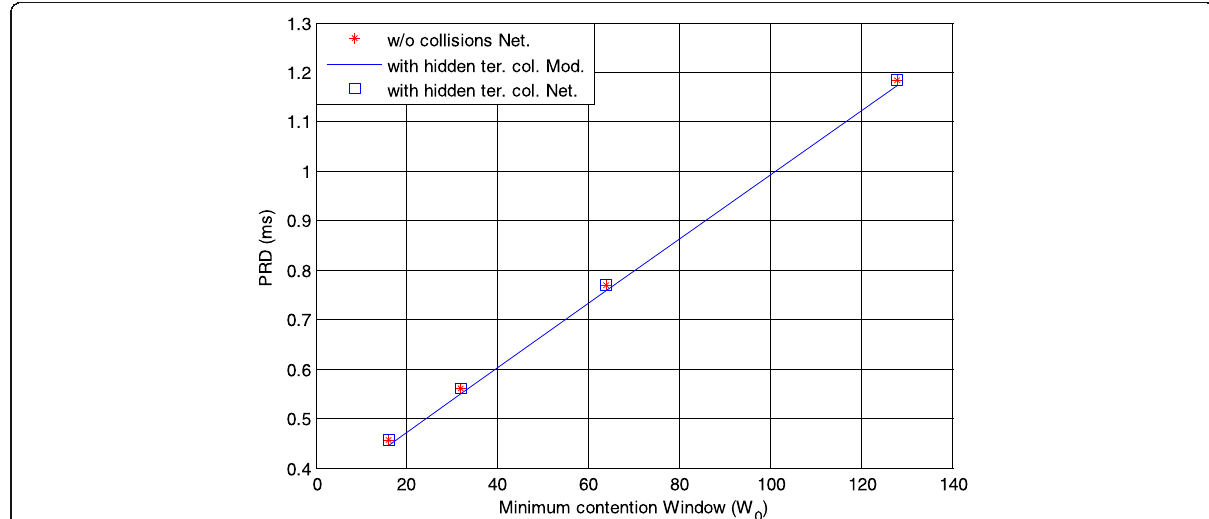
Fig. 18 PRD for the analytical model (Mod.) and for real network of Fig. 8 (Net.) with respect to minimum contention window size in case of hidden terminals and without, R = 6 Mbps, λ = 10 Hz, D = 186 B, R c = 250